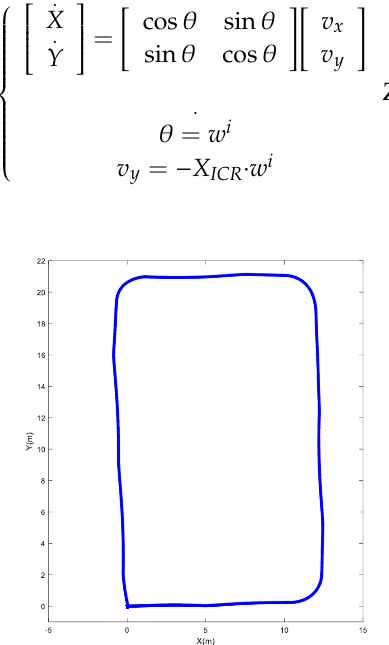
Figure 6. Dead reckoning results.